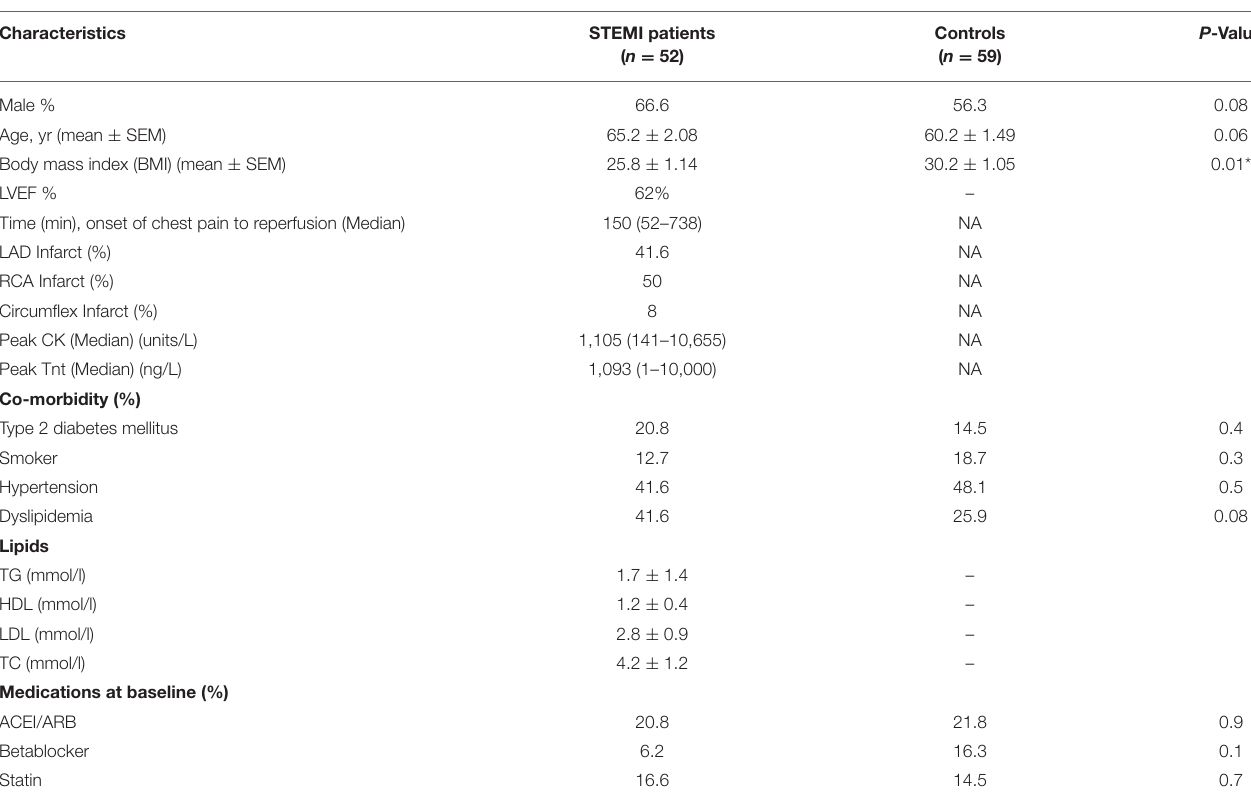
TABLE 1 | Characteristics of study participants. Characteristics STEMI patients